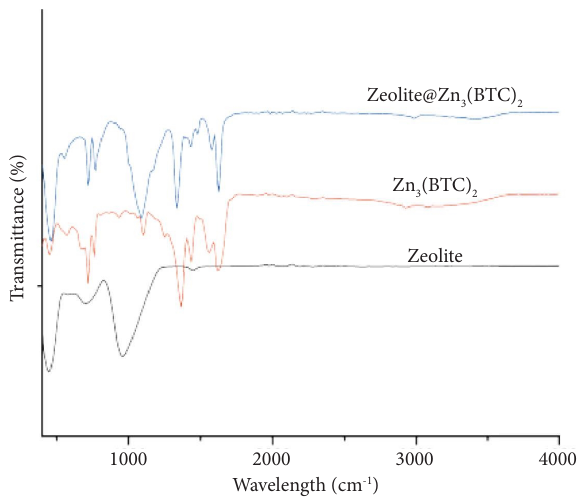
Figure 26: FTIR spectrum of zeolite, [Zn 3 (BTC) 2 ] and Zeolite@[Zn 3 (BTC) 2 ] adopted from